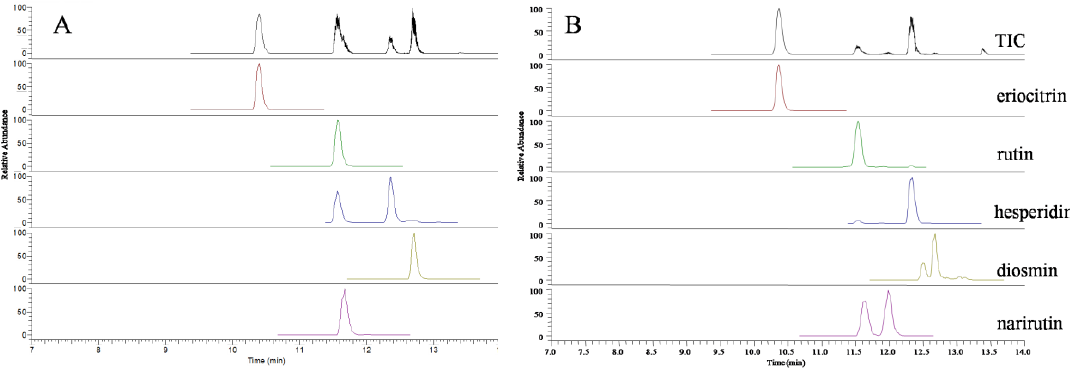
Figure 3. UPLC – QqQ/MS total ion count chromatograms of five flavonoid glycosides standards ( A ) Figure 3. UPLC–QqQ / MS total ion count chromatograms of five flavonoid glycosides standards ( A ) and commercial lemonade sample ( B ). and commercial lemonade sample ( B